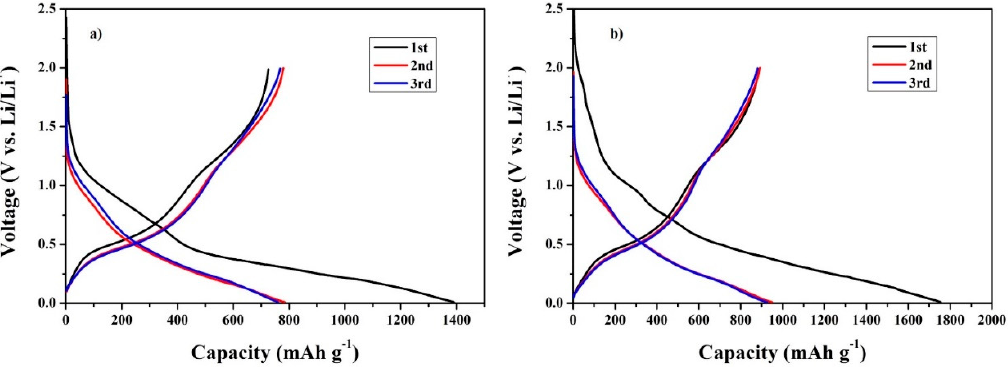
Figure 6. Initial voltage profiles of the ( a ) CNC–SnO 2 NF500 and ( b ) CNC–SnO 2 NF800 composite electrodes at 100 mA g − 1 .